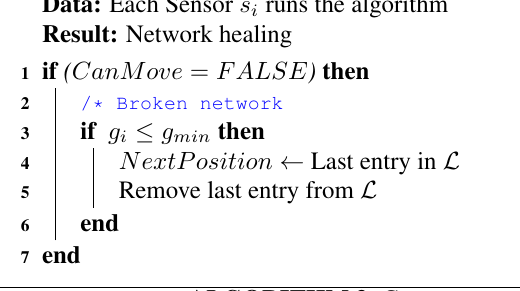
ALGORITHM 3: Compactness and robustness